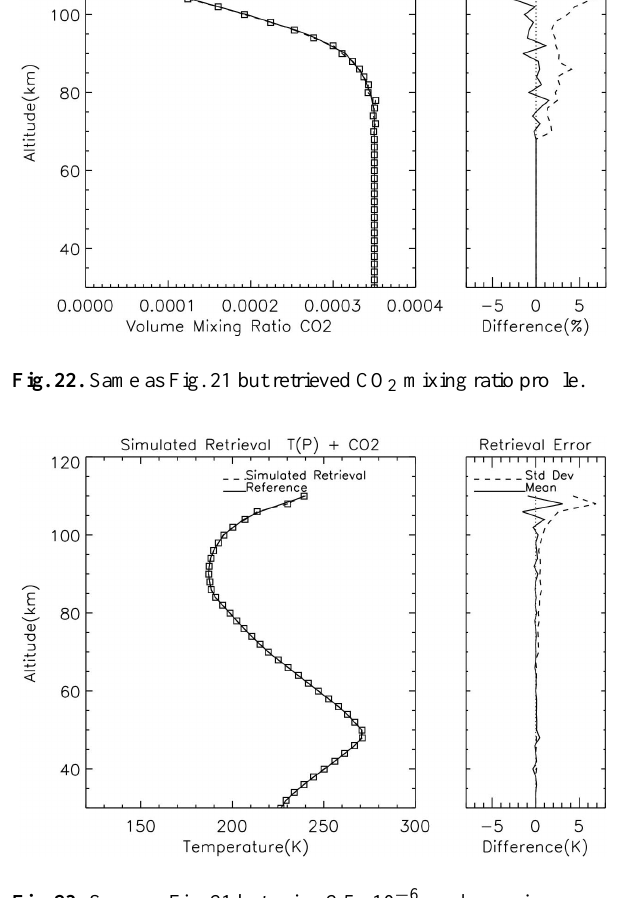
Fig. 23. Same as Fig. 21 but using 2 . 5 × 10 − 6 random